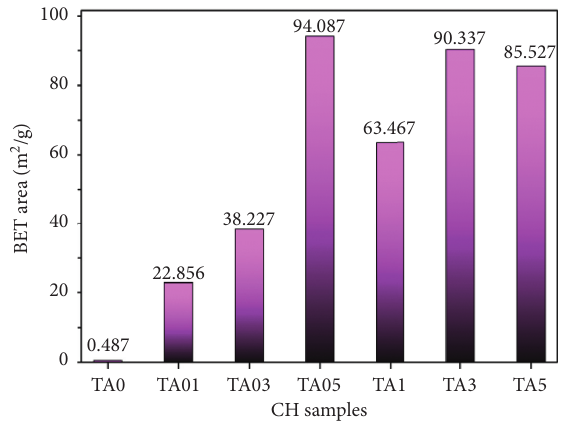
Figure 4: BET area of CH